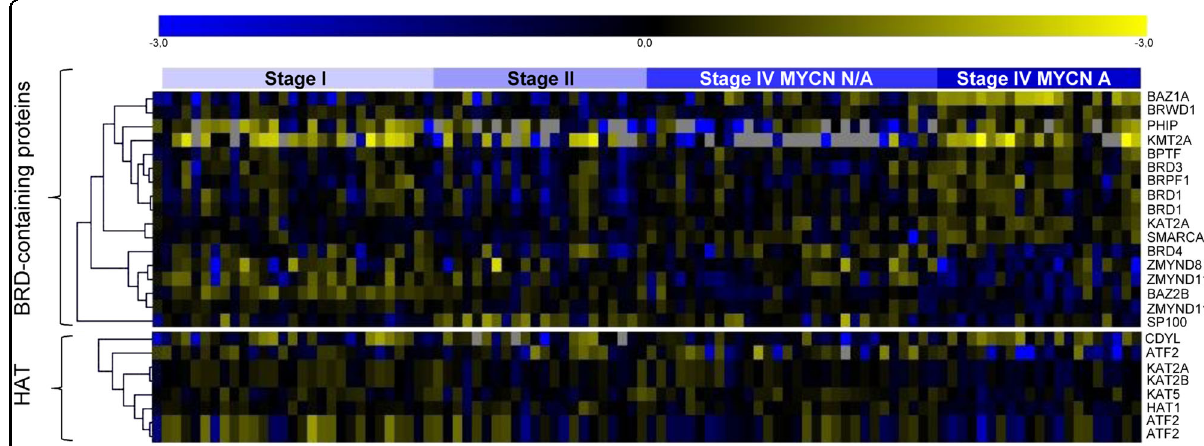
Fig. 3 In silico analysis of HAT and BRD-containing protein expression in NB. mRNA expression levels from 39 different BRD-containing proteins and 16 histone acetyltransferases were analyzed in neuroblastoma samples from the E-GEOD-3960 ( n = 101) dataset. Samples were sorted according to disease stage and MYCN status. Heatmap represents the differentially expressed genes ( p < 0.05) between the groups of patients with poor prognosis (stage 4, MYCN ampli fi cation) versus the remainder of patients (i.e., stage 1, 3, and 4 MYCN non-ampli fi